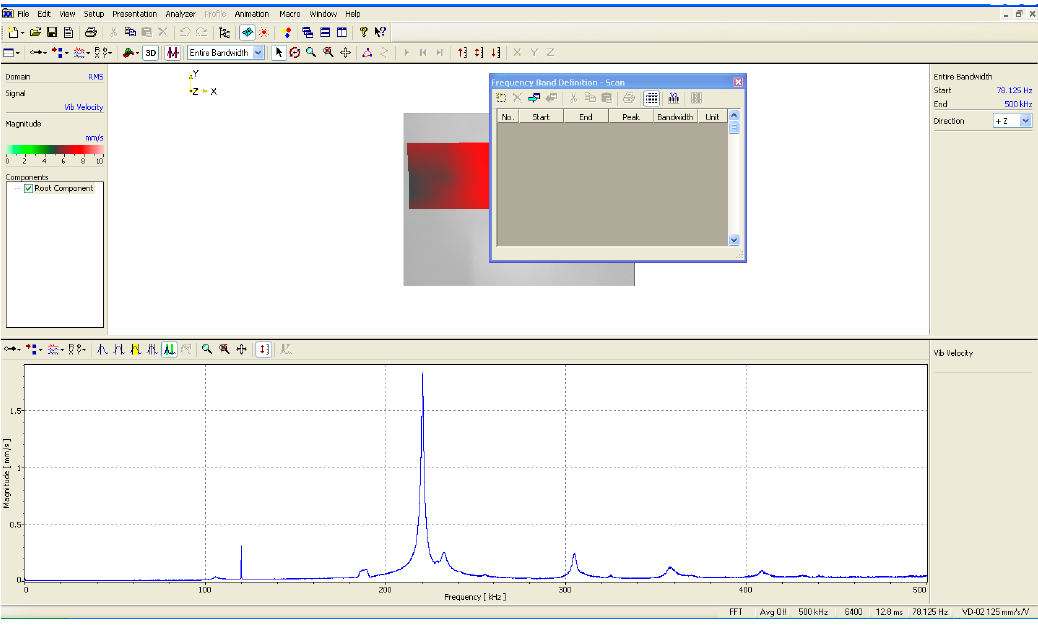
Figure 4. Frequency response of the piezoelectric material.